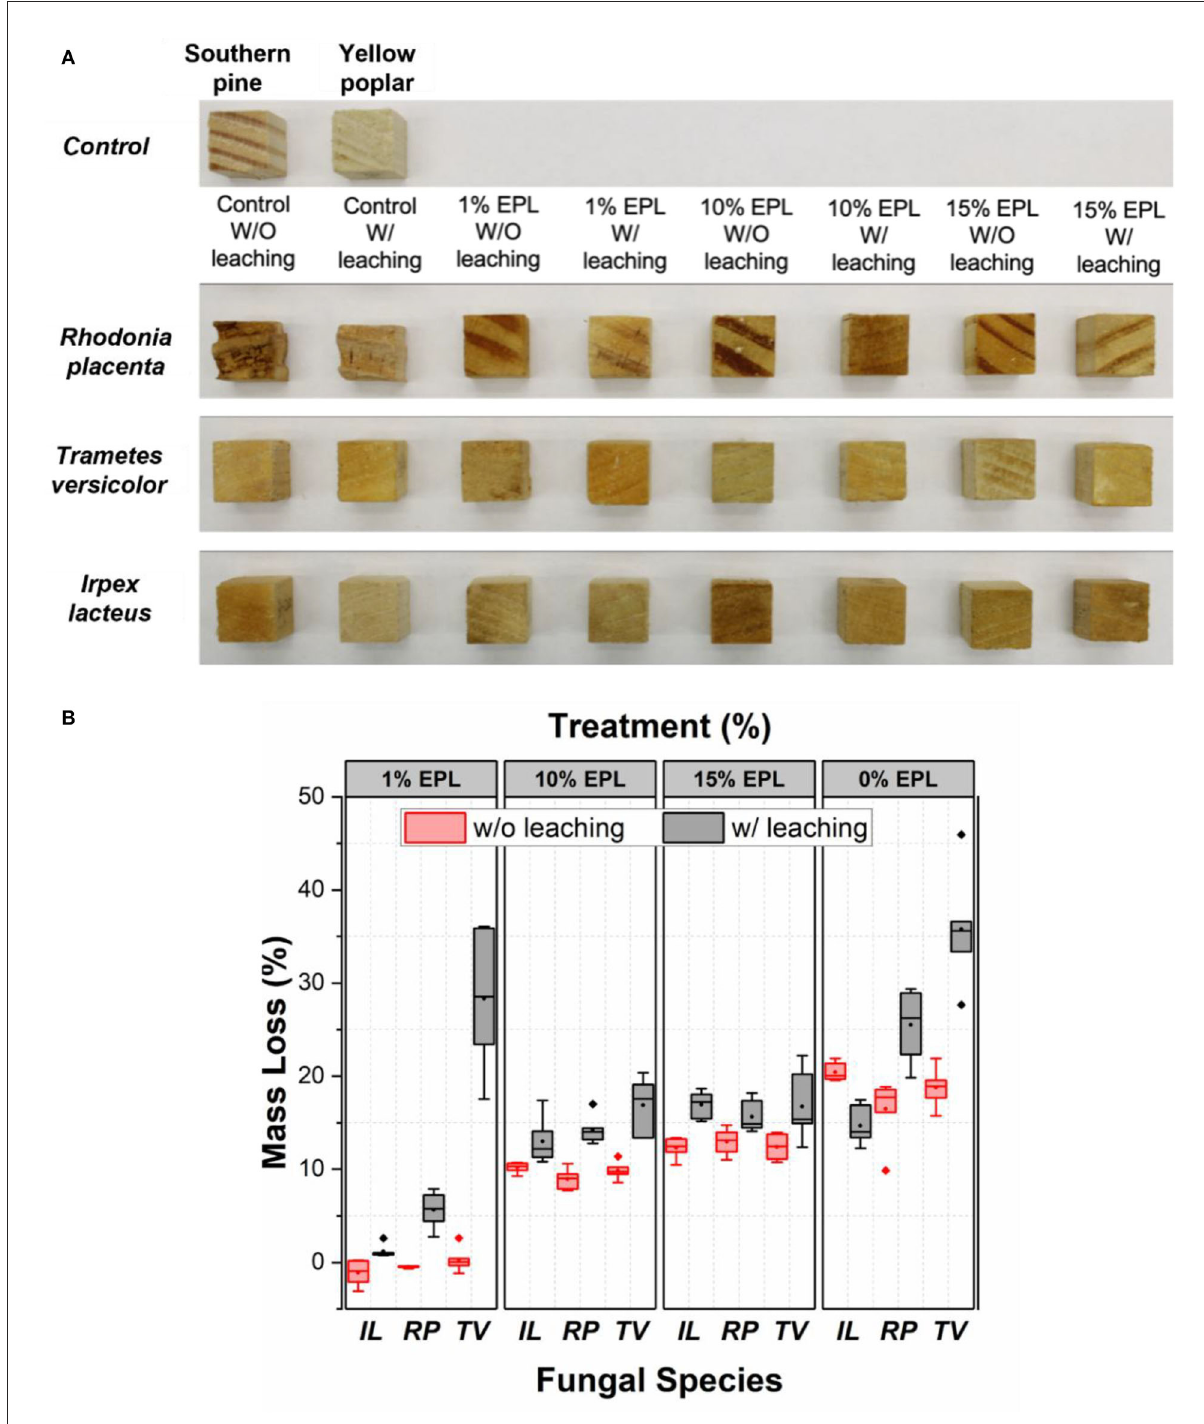
FIGURE6 (A) Photos and (B) mass loss of wood cubes with different treatments after 8 weeks of fungal exposure. In total, six replicates were used. The brown-rot fungus R. placenta was inoculated into southern pine samples, while white-rot fungi, T. versicolor and I. lacteus , were inoculated on yellow poplar